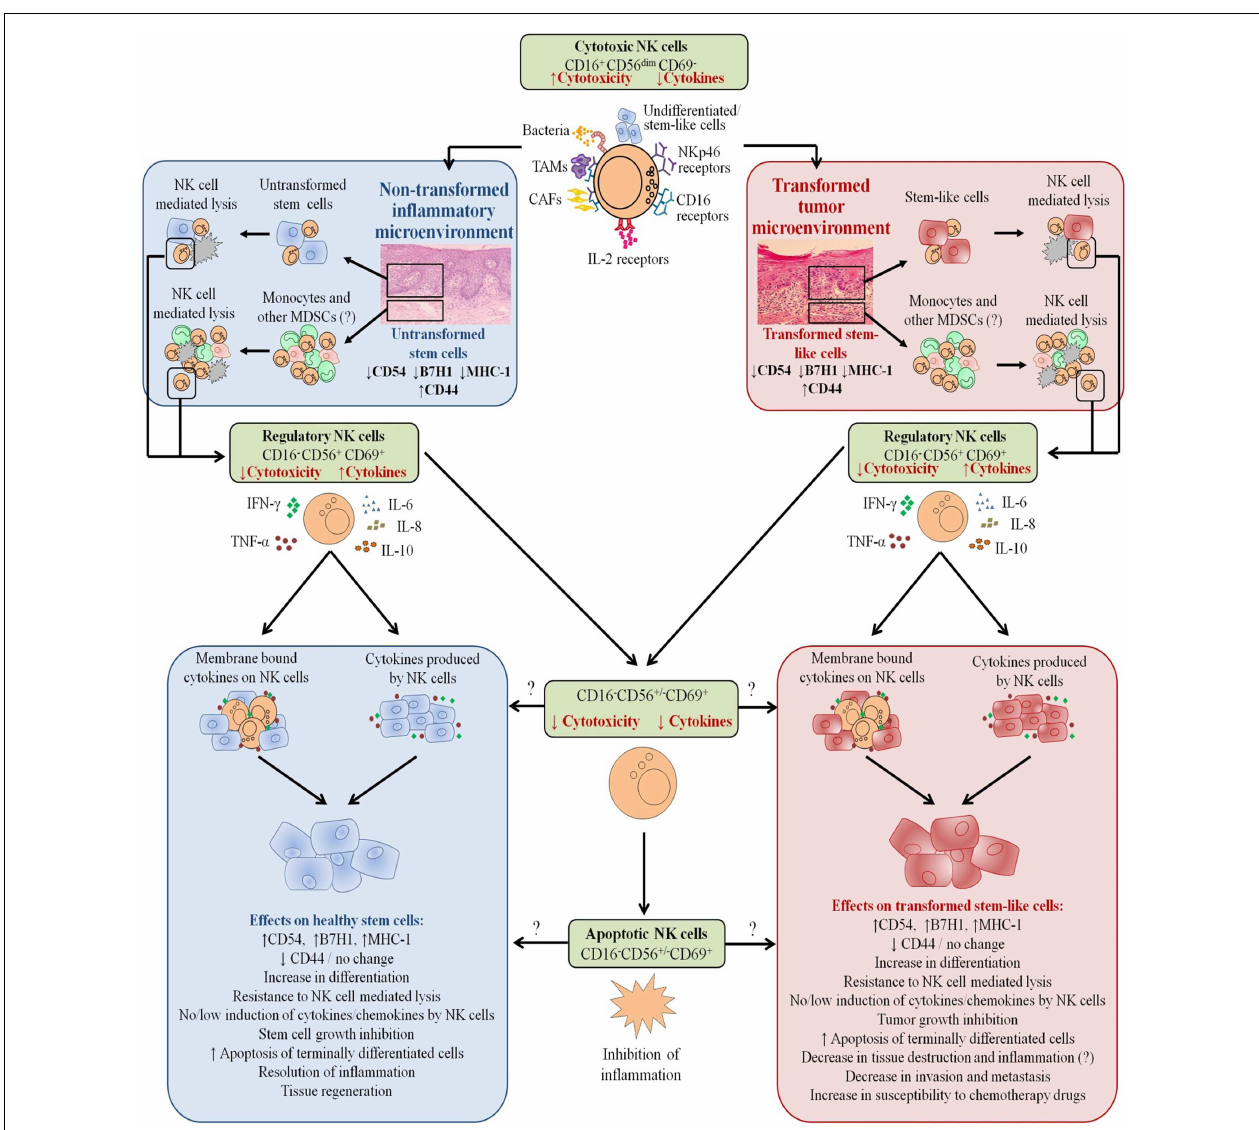
the basal epithelial layer containing stem cells. NK cells are likely to encounter and interact with other immune effectors such as monocytes/macrophages or other myeloid-derived suppressor cells (MDSCs), or with connective tissue-associated fibroblasts (CAF), in order to be conditioned to form anergized/regulatory NK (NKreg) cells. NK cells may also directly interact with stem cells at the base of the epithelial layer, in which case by eliminating their bound stem cells, they can become conditioned to support differentiation of other stem cells. NK cell-differentiated epithelial cells will no longer be killed or induce cytokine secretion by the NK cells, resulting in the resolution of